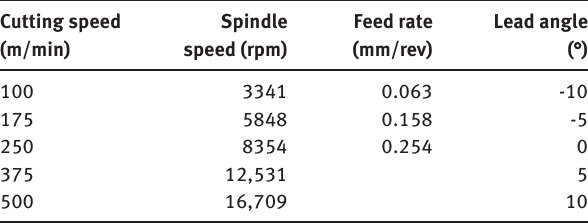
Table 2: Cutting parameters.